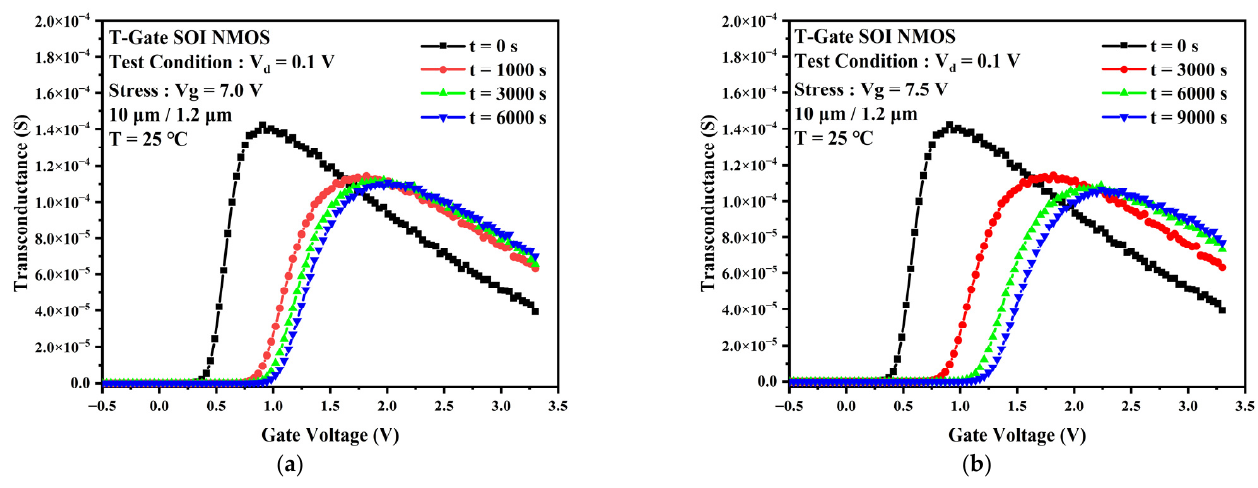
Figure 3. Degradation of the device threshold voltage when the TDDB stress is applied.